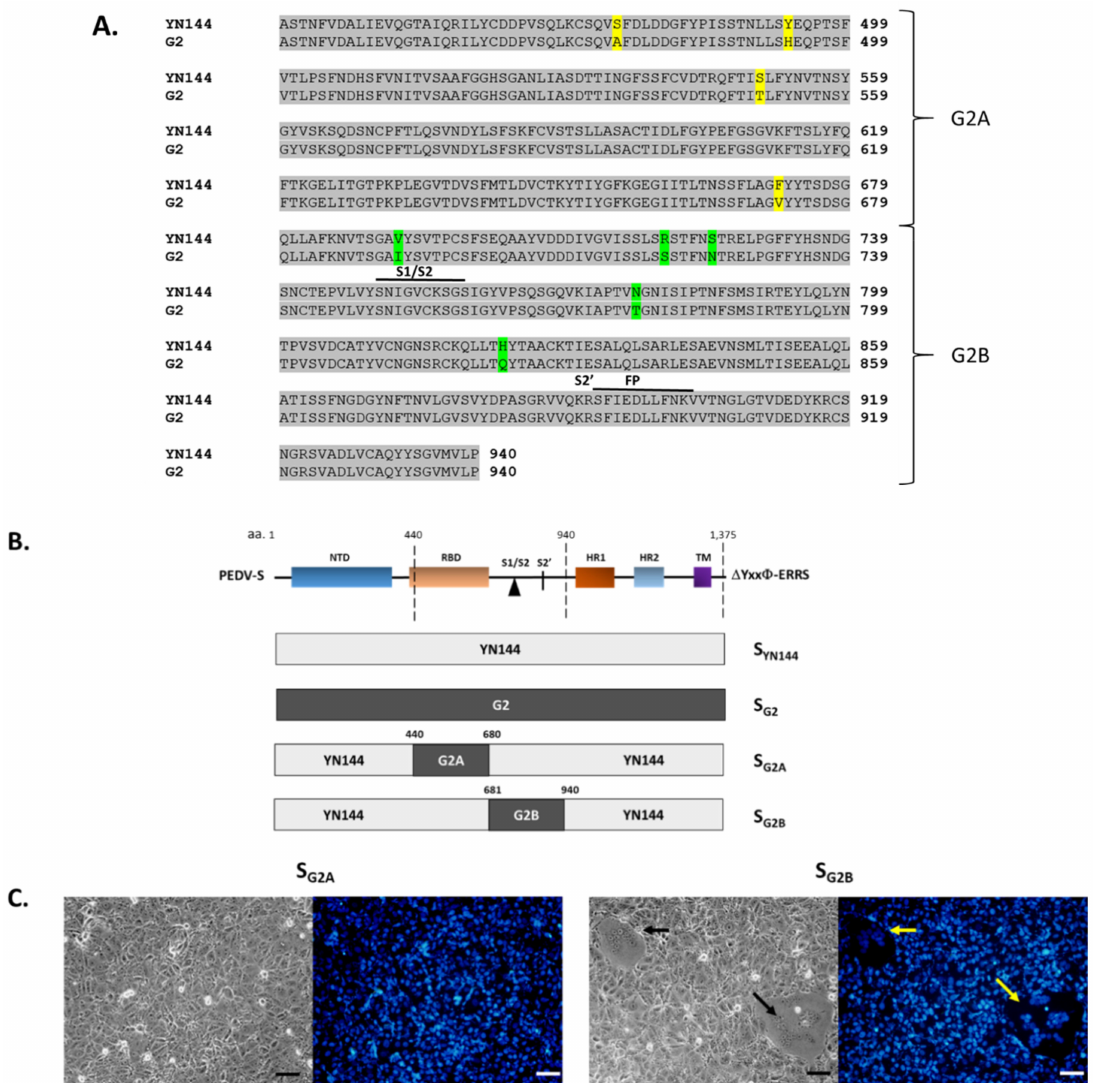
Figure 4. RBD plays a key role in the syncytium formation in VeroE6-APN cells. ( A ) Amino acid alignment between S YN144 and S G2 in the region covering the RBD and S1/S2 cleavage site. Colored residues are those that are different between the two strains. ( B ) Schematic representation of chimeric PEDV S in which the RBD or the S1/S2 cleavage site of S YN144 was replaced with that of S G2 . ( C ) VeroE6-APN cells were transfected with pCAGGS expressing the chimeric S G2A and S G2B and cultured in the presence of trypsin. At 24 hpt, cells were evaluated for syncytium formation. Hoechst was used to stain nuclei. Arrows denote the formation of the syncytium. Scale 50 µ